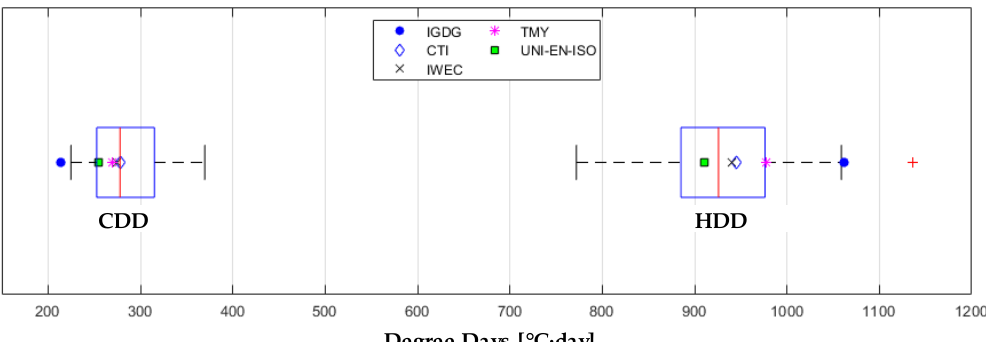
Figure 10. Heating degree days (HDD) and the cooling degree days (CDD): Comparison among typical years and long-term distribution.